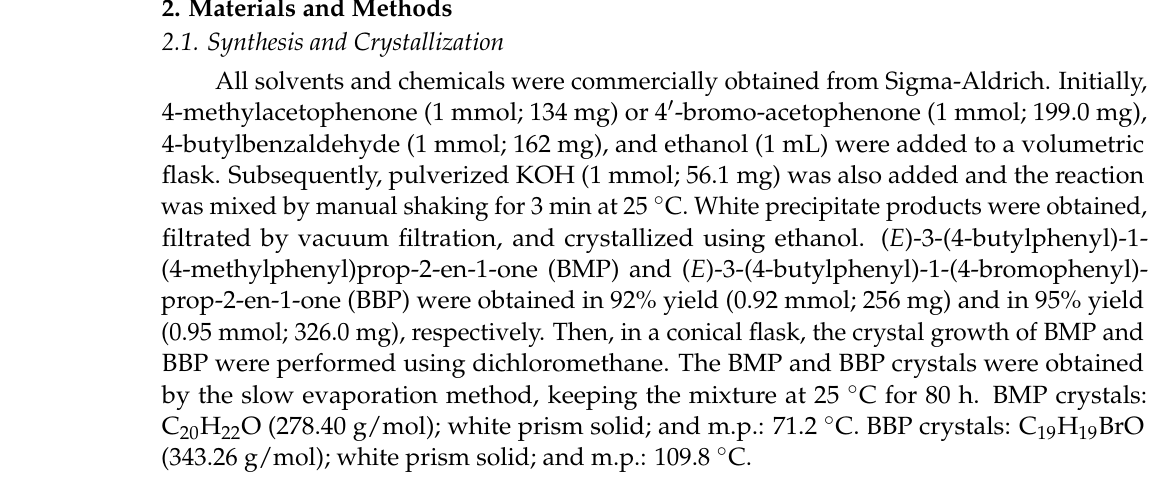
Figure 1. Molecular structures of ( E )-3-(4-butylphenyl)-1-(4-methylphenyl)-prop-2-en-1-one (BMP) and ( E )-3-(4-butylphenyl)-1-(4-bromophenyl)-prop-2-en-1-one (BBP).